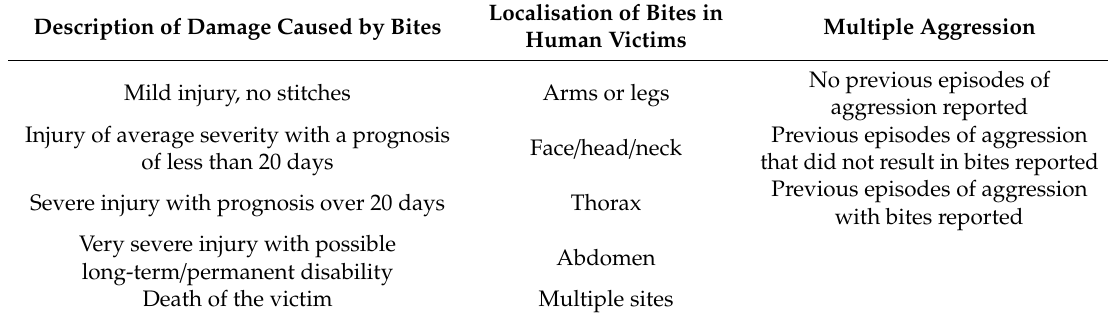
Table 2. Descriptions of severity of bites, site of bites in human victims and history of multiple aggressive